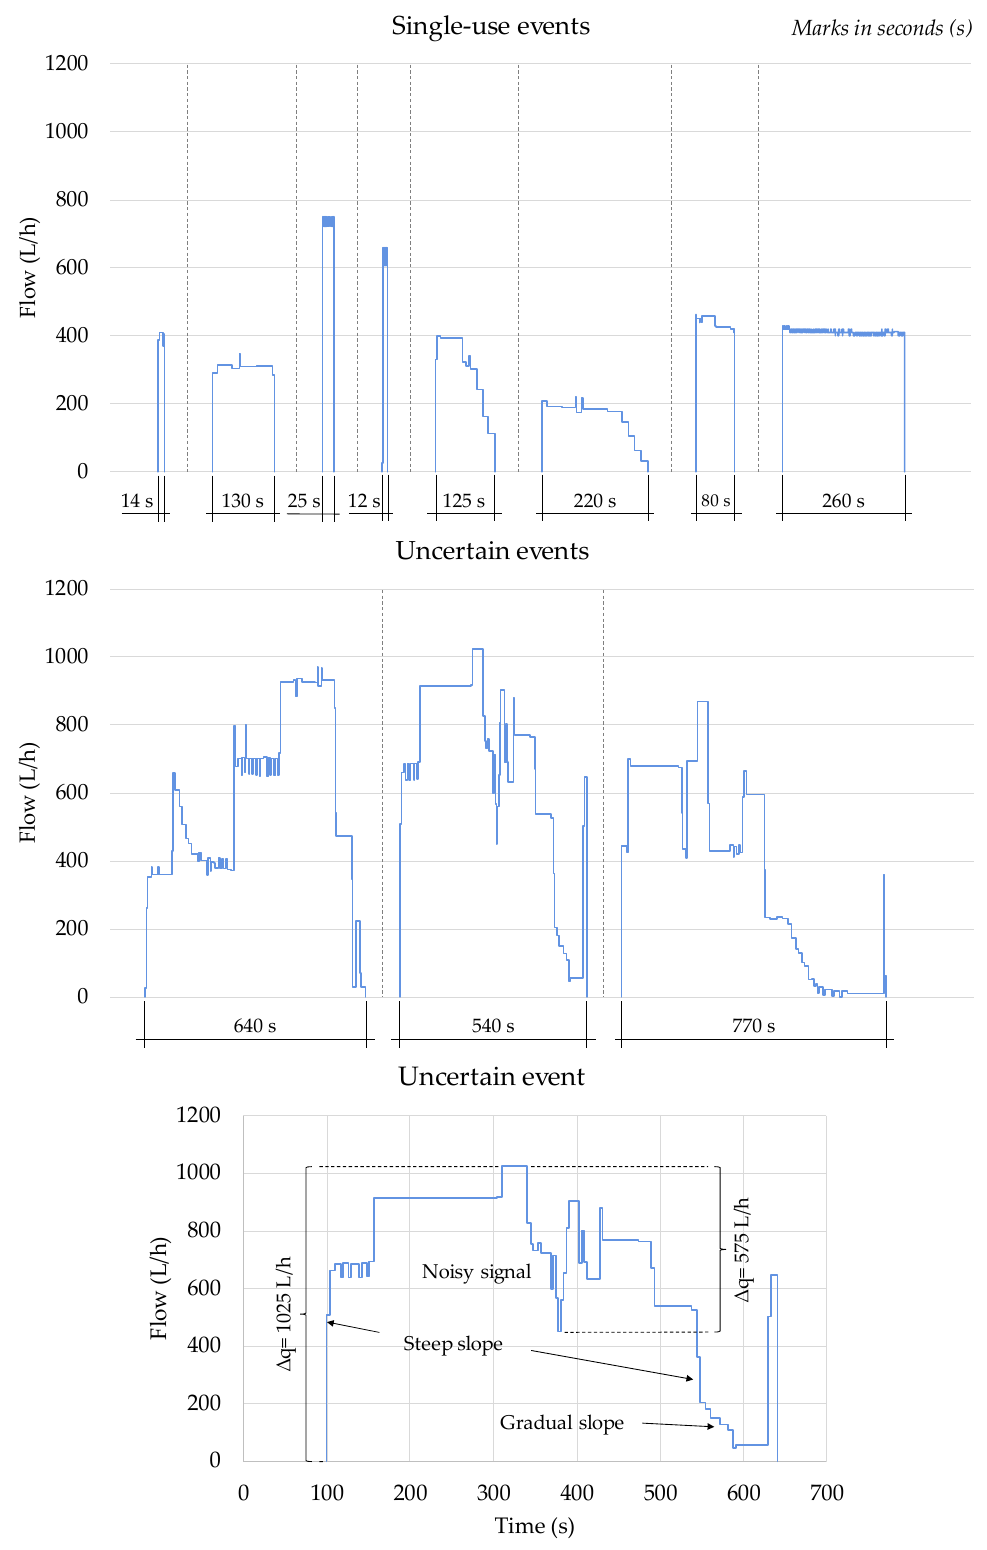
Figure A1 . Examples of Single ‐ Use and Uncertain Events. Figure A1. Examples of Single-Use and Uncertain